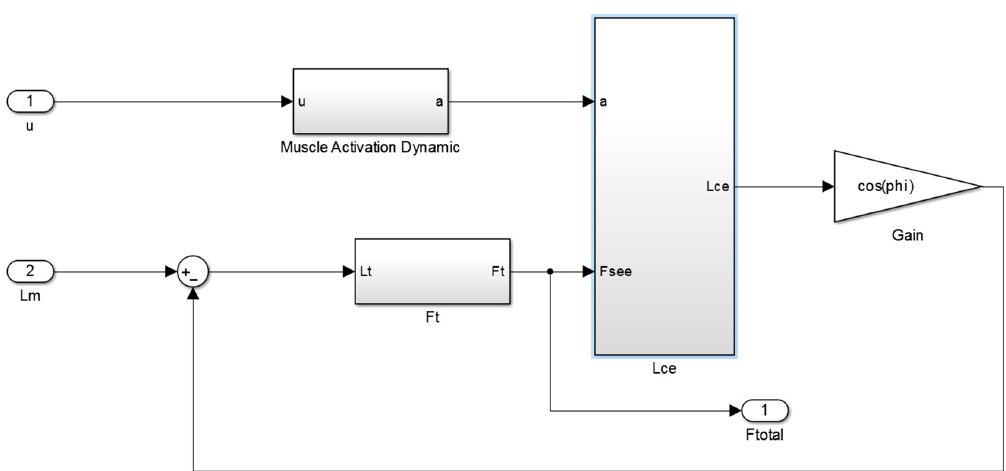
Figure A2. Implementation of Thelen Figure A.2. Implementation of Thelen Model Figure A.2. Implementation of Thelen Model